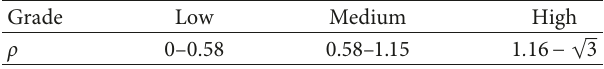
Table 3: Grade standard of the sustainability.